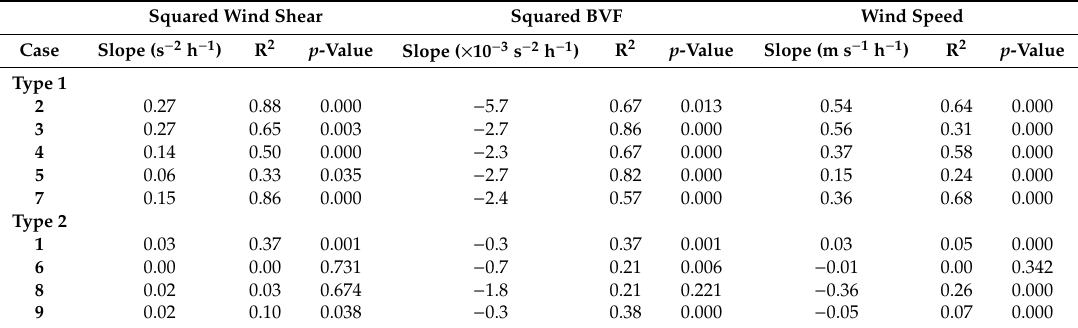
Table 3. The simple linear regression slopes of parameters with time from all cases. Squared Wind Shear Squared BVF Wind